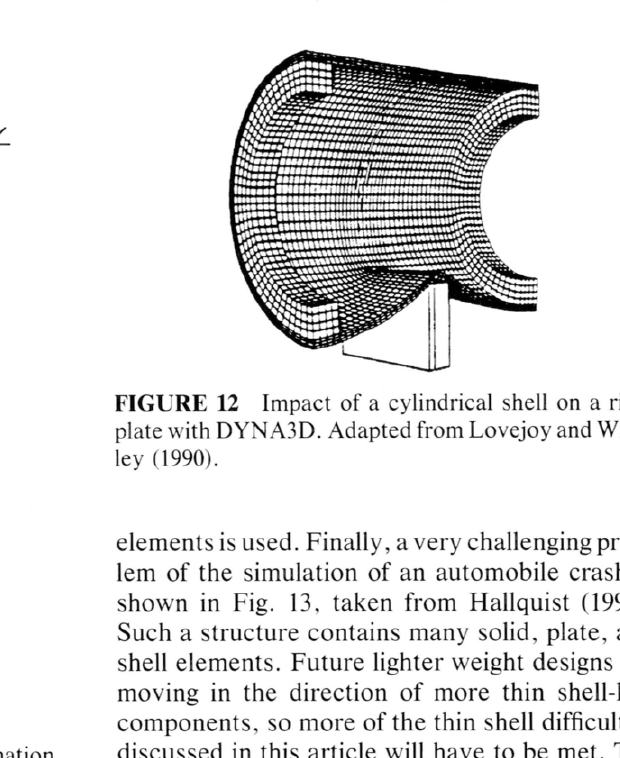
FIGURE 11 Impact of shells. For large deformation of shells, the shell will generally have regions of inex tensional bending divided by narrow regions of edge bending. In (a) a spherical shell impacts a rigid wall and in (b) a mass strikes a spherical shell. In both a dimple forms with the same curvature as the original shell. For elastic deformation, the significant strain en ergy is in the narrow transition region. When the elastic limit is exceeded, plastic flow occurs in the transition region. Note that a fixed point on the shell experiences plastic bending and then reversed bending, so unload ing must be handled properly. As the dimple progresses further, asymmetric bifurcations in the deformation shape usually take place.